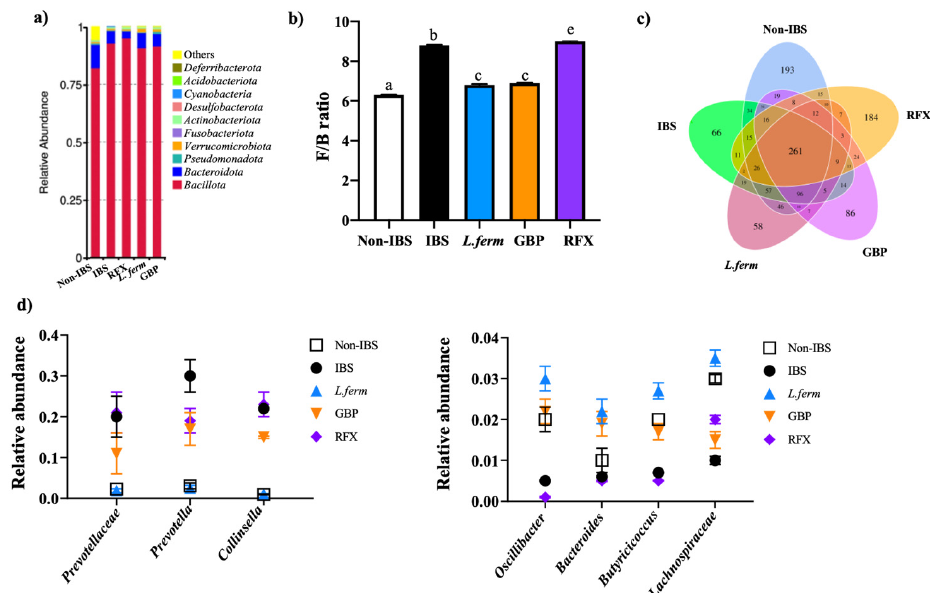
Figure 10. Impact of L. fermentum administration on microbiota composition of DCA vehicle (Non- IBS), 4 mmol/L DCA (IBS)-, L. fermentum (10 9 CFU) ( L. ferm )-, Gabapentin at 70 mg/kg (GBP)- and Rifaximin at 150 mg/kg (RFX)-treated rats. ( a ) Distribution histogram of relative abundance of phylum taxa. ( b ) Bacillota / Bacteroidota (called F/B) ratio in each experimental group. ( c ) Venn diagram showing the number of OTUs unique and common to each group. ( d ) Taxonomic signatures at genus level. Data are presented as mean ± SEM. Bars with different letters are statistically different ( p < 0.05).